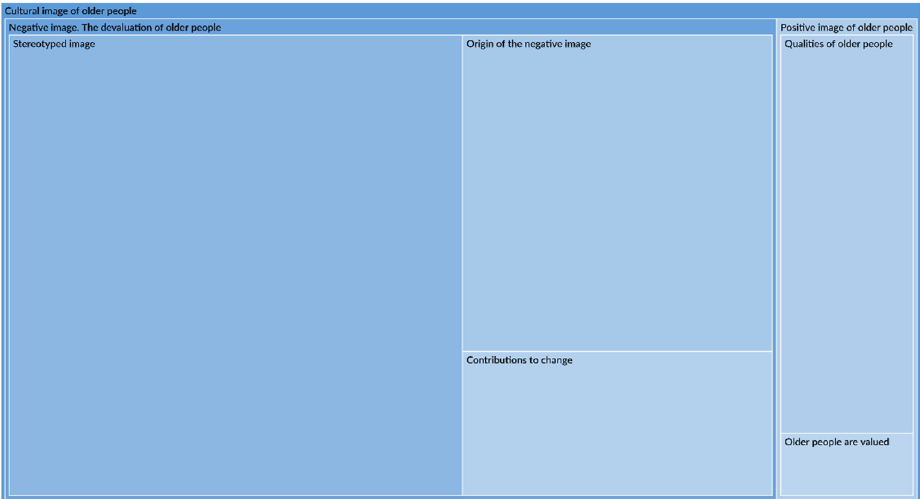
Figure 1. Hierarchy chart of codes. Cultural image of older people .